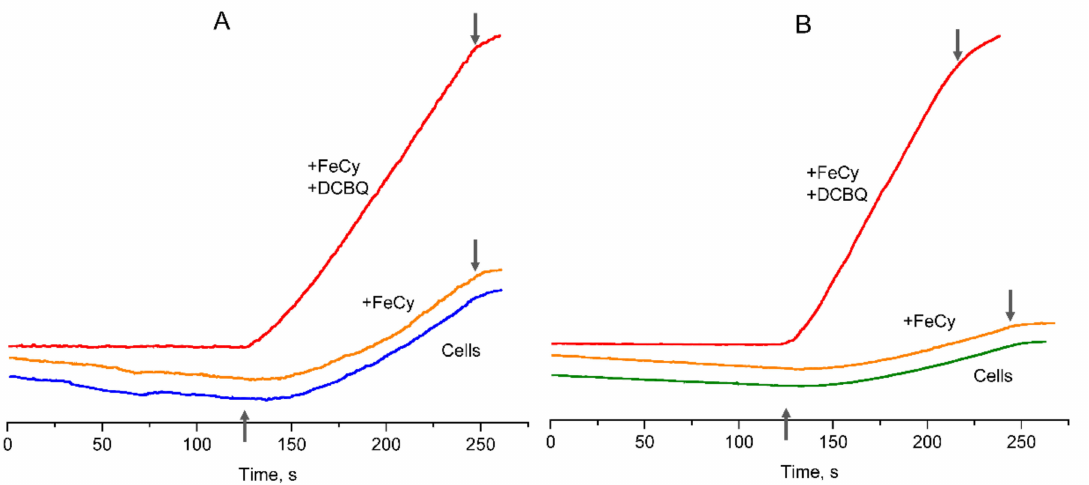
Figure 3. Curves of O 2 evolution observed in the suspension of living cells of C. reinhardtii strains: CC-503 ( A ) and 137c ( B ). Blue and green (CC-503 and 137c, respectively) lines correspond to cells without additions, orange lines refer to cells in the presence of 0.5 mM FeCy, red lines refer to cells in the presence of 0.5 mM FeCy and 0.2 mM or 0.1 mM DCBQ in the case of CC-503 or 137c cells, respectively. ↑ and ↓ indicate approximate moments when the actinic light was switched on and switched